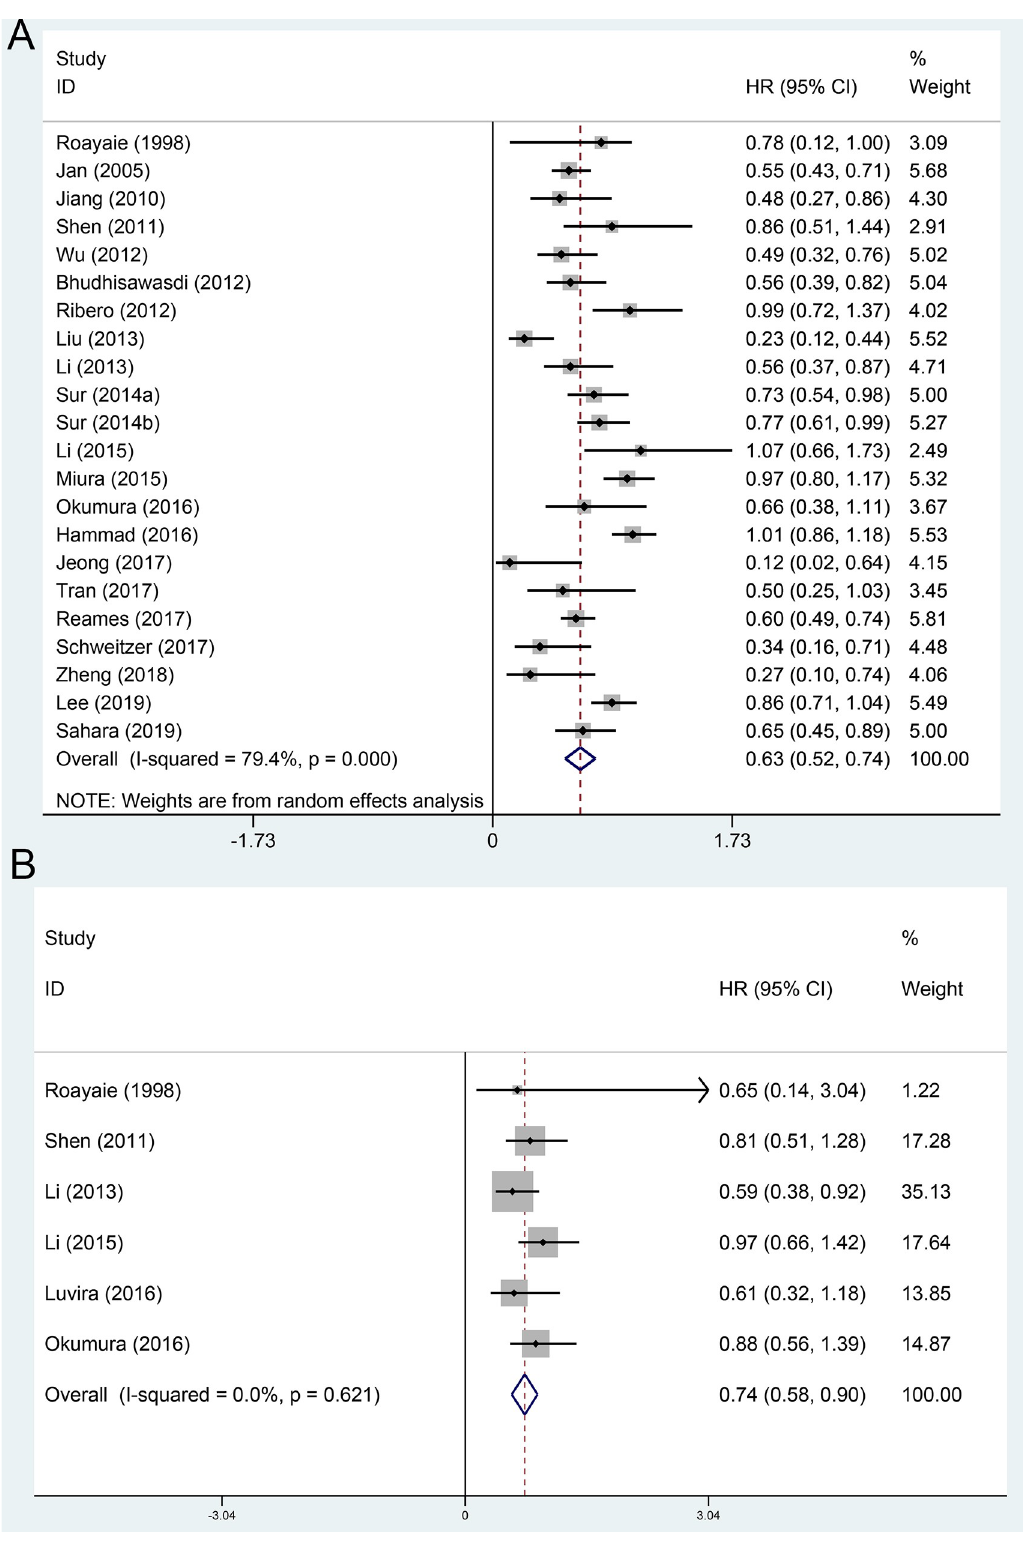
PLOS ONE | https://doi.org/10.1371/journal.pone.0229292 February 21,